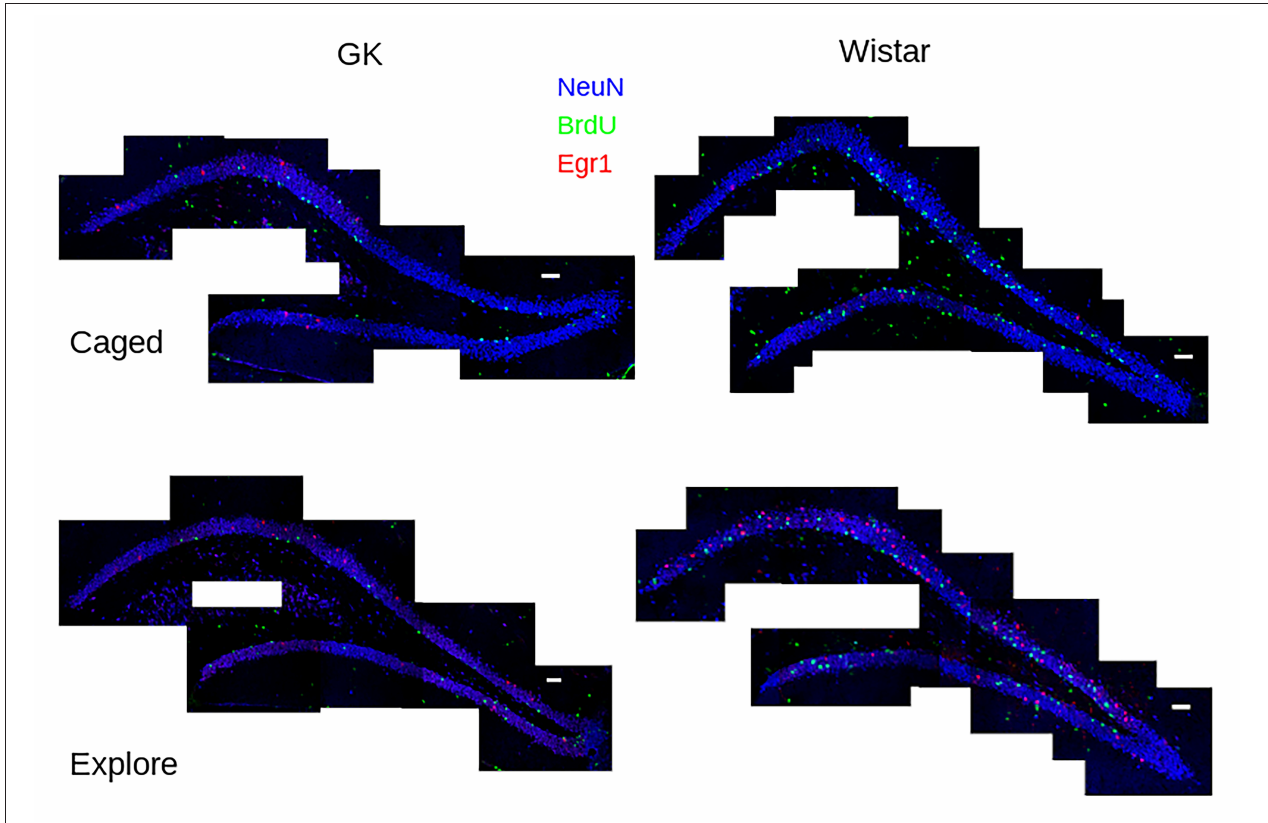
FIGURE 1 | Task-dependent Egr1 transcription. Sample tile-scans (scale bar = 100 µ m) show Egr1 (red) BrdU (green) and NeuN (blue) in the dorsal dentate gyrus from each group. Fewer BrdU + cells can be seen in GK rats (left) compared to Wistars (right) in both groups. These images show that caged control (caged, above) rats of both strains show few Egr1 + GCs. A robust up-regulation of Egr1 can be seen, largely in the suprapyramidal blade, in both strains of rats that engaged environmental exploration (Explore, bottom), although more robust Egr1 expression occurs in